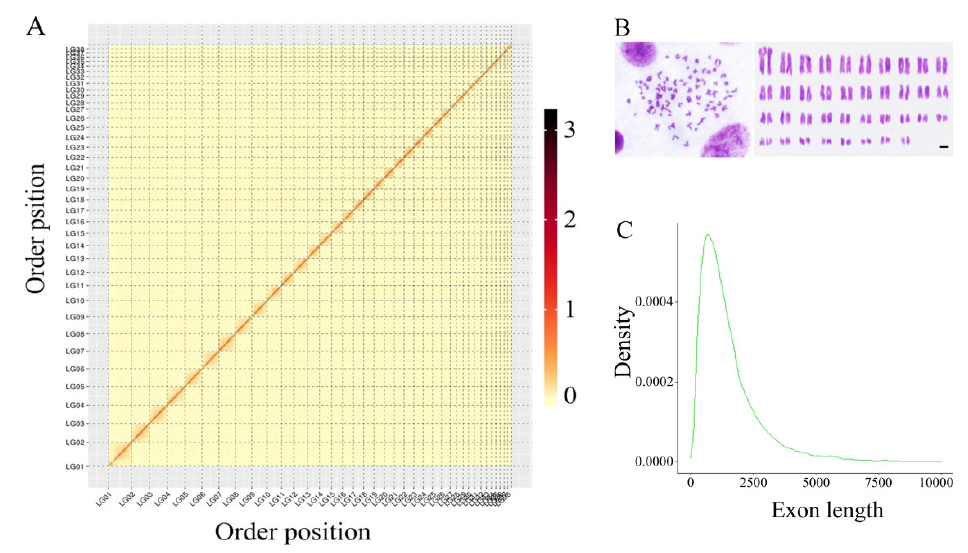
Figure 1. The Hi-C heatmap, karyotypes, and exon length of the male O. bidens . ( A ) A Heat map generated by Hi-C technology presented contact matrices of thirty-eight chromosomes. The color bar indicates the logarithm of the strength of the contact density. ( B ) The karyotypes of male O. bidens ’ genome. ( C ) The distributions of gene exon length in male O. bidens ’ genome.